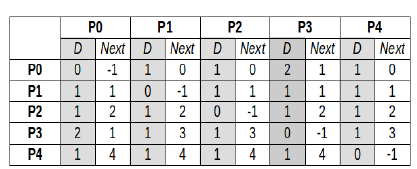
Figure 14. Routingtables after 2 steps.